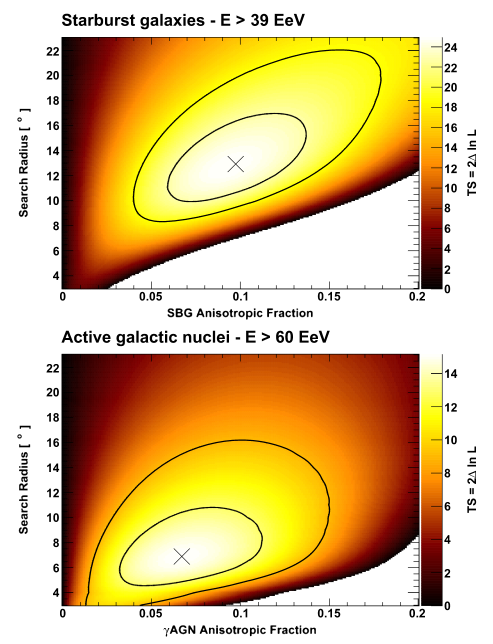
Figure 9. TS profile above 39 EeV (top) and 60 EeV (bottom) over the fit parameters for SBG and γ AGN models . The lines indicate the 1 σ 2 σ −